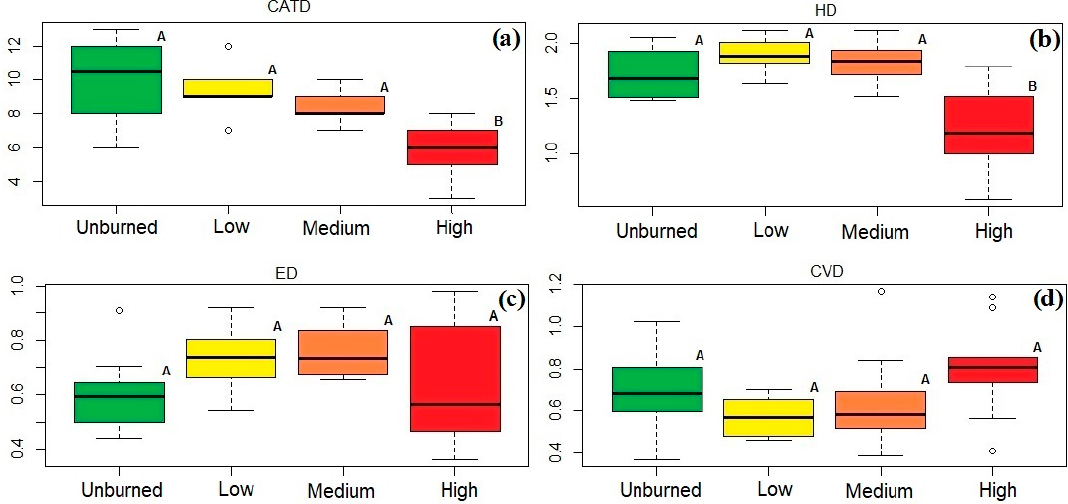
Figure 4. Tukey’s multiple comparison test for ( a ) number of diameter categories ( CATD ), ( b ) Shannon index of diameter categories ( H-D ), ( c ) Evenness Index of diameter categories ( E-D ), and ( d ) the coefficient of variation for diameter categories ( CV-D ) by fire severity level. Different letters indicate that means were significantly different ( p ≤ 0.05); the same letters indicate non-significant differ- ences.